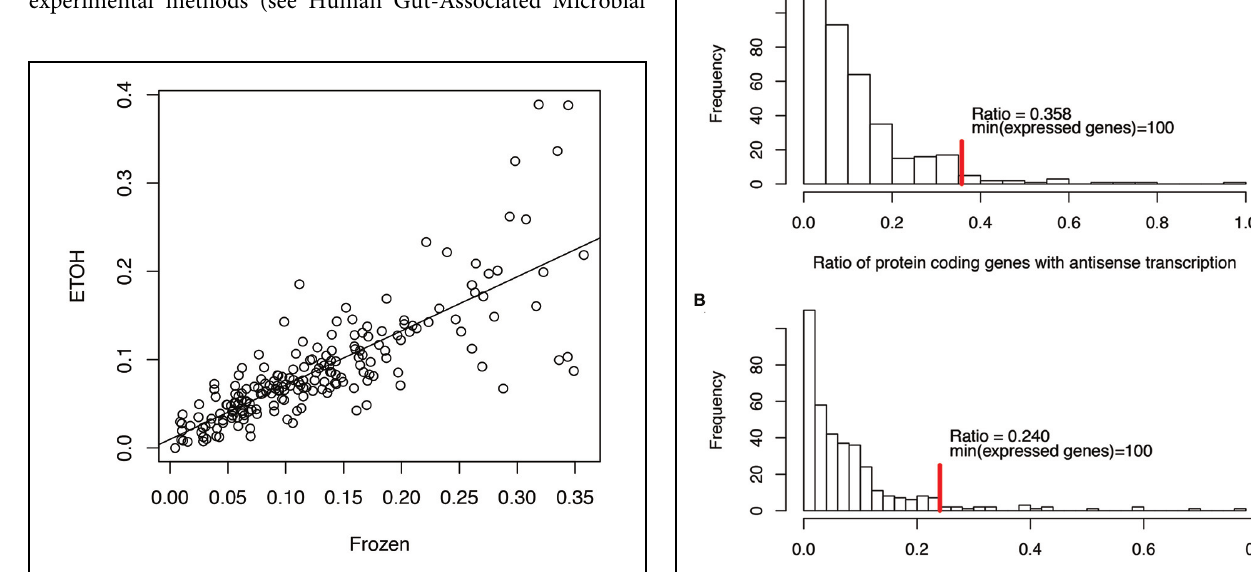
FIGURE 1 | Impacts of different experimental protocols on the profiling of antisense transcription. The figure shows the correlation (and differences) between the profile of antisense transcription (i.e., ratios of genes with antisense transcription in different species across individuals) for frozen samples and the profile of antisense transcription for ethanol-fixed samples (Pearson’s r = 0.71; two tailed p -value < 2.2e-16). In this plot, the ratios of genes with antisense transcription for the different species based on the frozen samples (Frozen) and ethanol-fixed samples (ETOH) are plotted in the x-axis and y-axis, respectively.